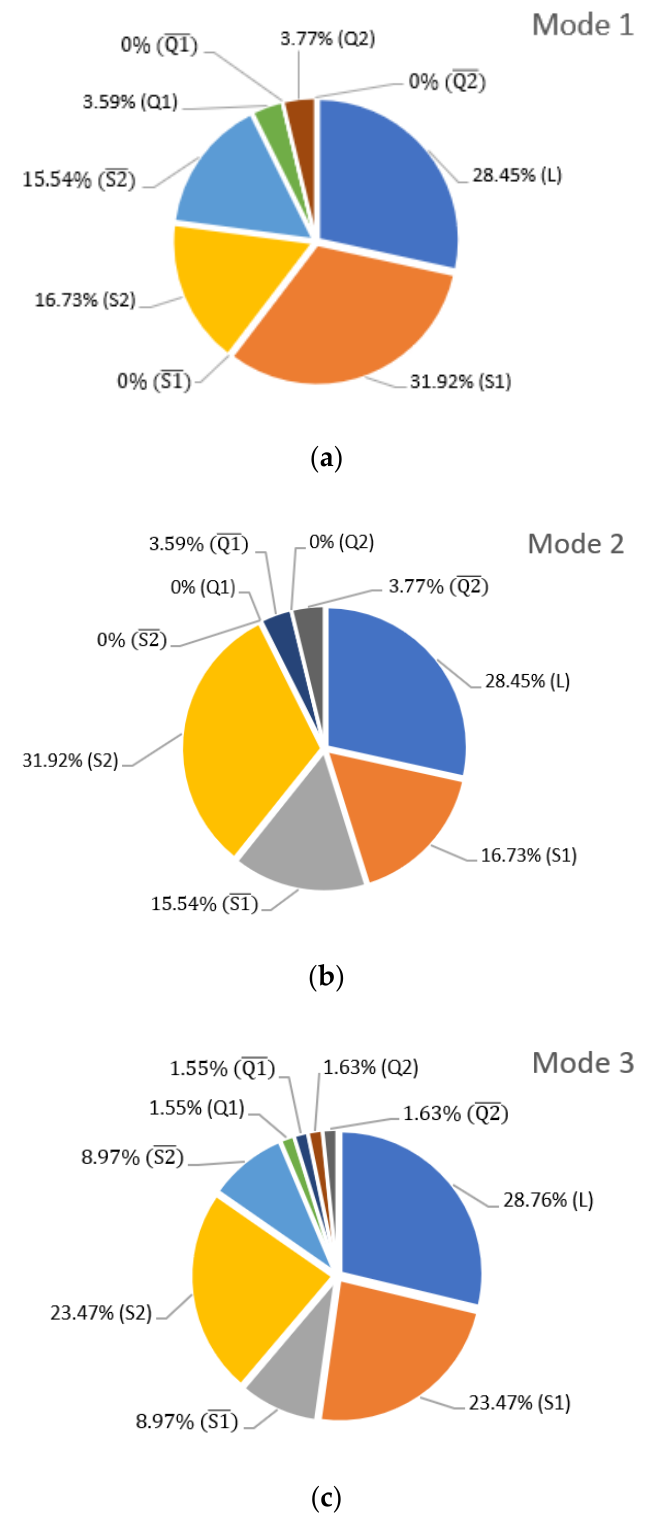
Figure 12. Power loss distribution of the experimental prototype operating in: ( a ) mode 1 at d = 0.5 (efficiency = 97.9%), ( b ) mode 2 at d = 0.5 (efficiency = 97.9%), and ( c ) mode 3 at G = 1.0 (efficiency = 97.6%).